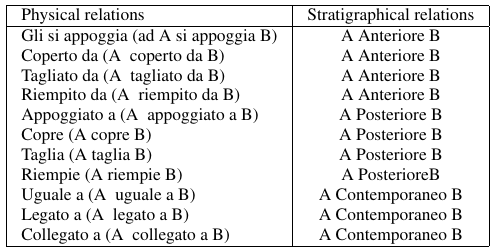
Table 1. Links between physical relations and stratigraphy